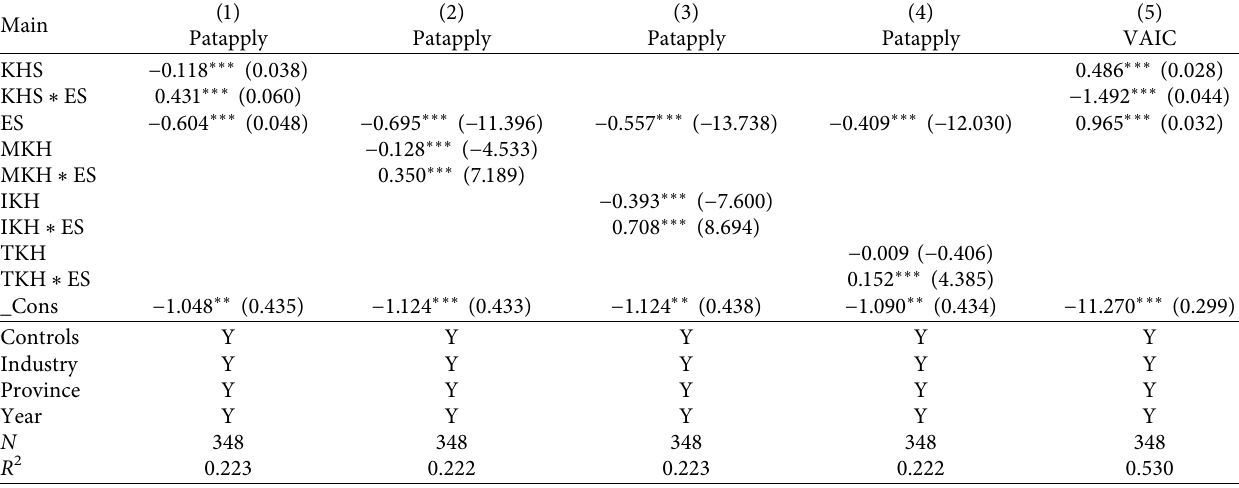
Table 6: Moderating Effect of equity